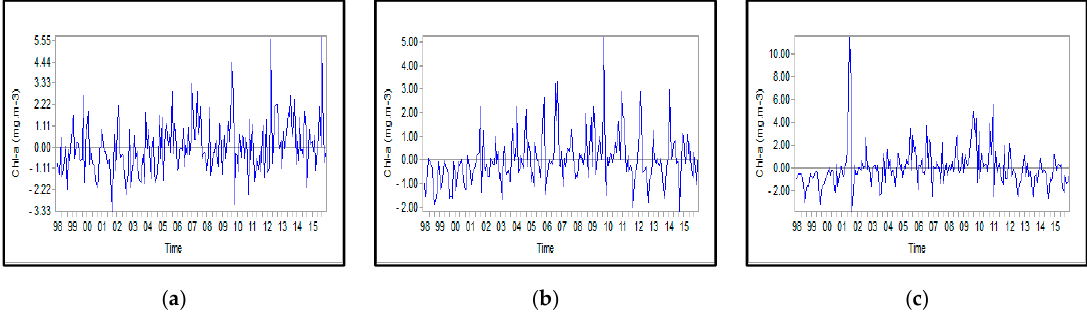
Figure A11. Monthly anomalies of Chl-a concentration for: ( a ) Northern, ( b ) Middle, and ( c ) Southern Caspian Sea